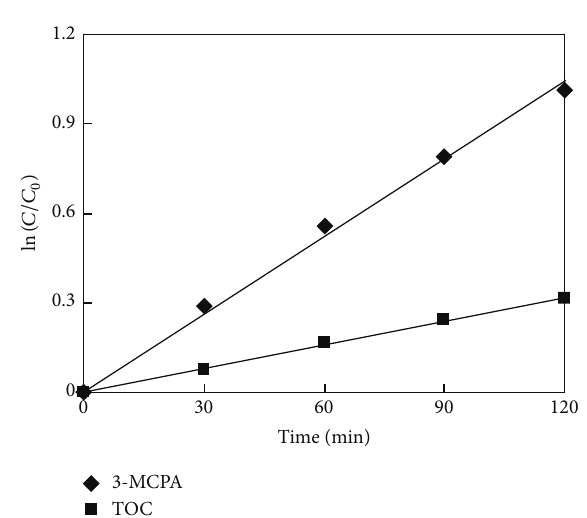
Figure 4: Kinetical plots in CGDE of 3-MCPA ( 𝐶 0 : 5.0 mmol/L).